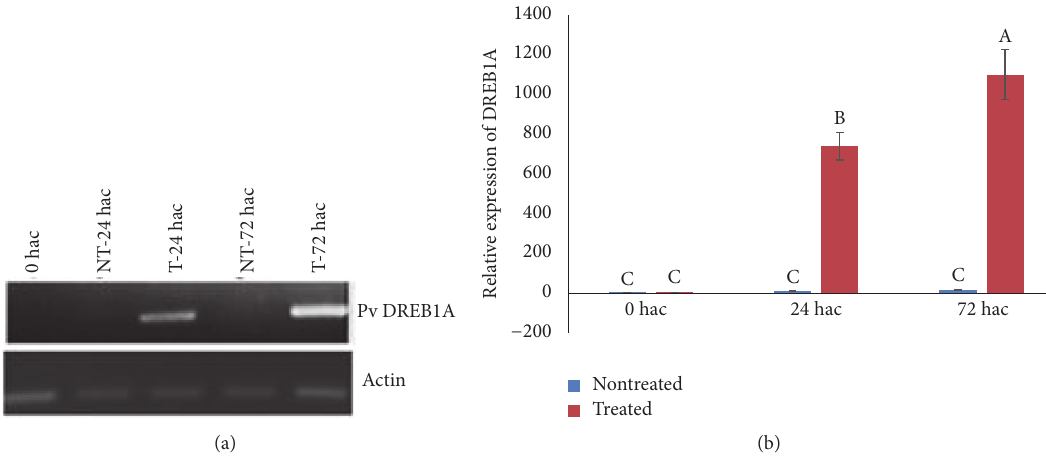
Figure 6: Expression analysis of DREB1A, a cold responsive gene after subjecting common bean plants to cold treatment at 4 ∘ C at different time points. Leaf tissues were collected from control and cold treated plants 24 and 72 hours after treatment. (a) cDNA PCR performed after RT-PCR of samples using DREB 1A and Actin primers. (b) qPCR to determine relative expression of DREB 1A during cold stress. Three biological andthreetechnical replicates wereused fortheanalysis. Data wereanalyzed by analysisofvariance (ANOVA) using[SAS]statistical software. Differences between treatments were assessed by Tukey’s Studentized Range (HSD) Test for experiment. The different letters A, B, and C indicate significant difference in gene expression between times of cold treatment at 𝑝 < 0.0001 . Values with the same letters are not statistically different.